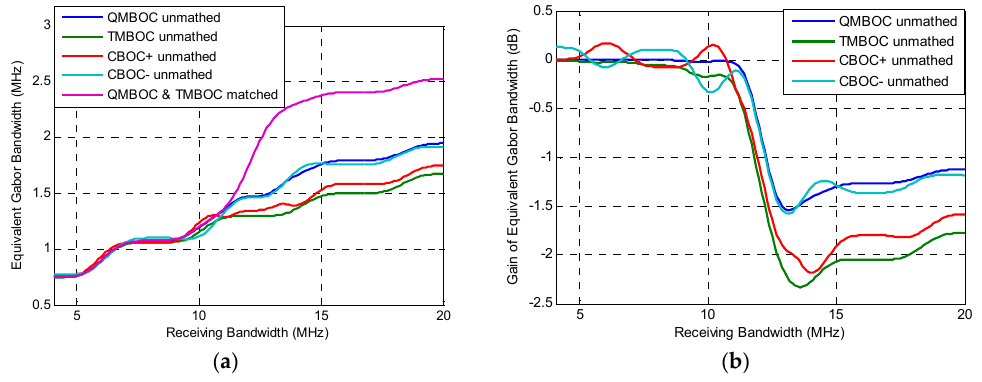
Figure 7. Equivalent Gabor bandwidth of for implementations of MBOC(6,1,1/11), under matched receiving and BOC 11 -like unmatched receiving, representing the code tracking performance.